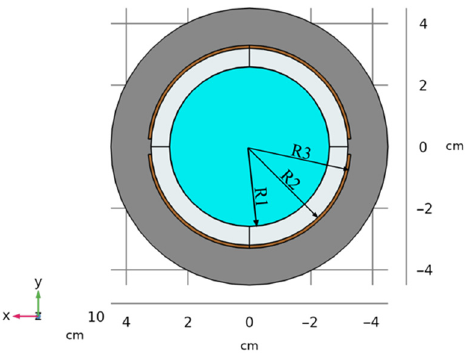
Figure 7. Cross-section diagram of the simulated capacitance-based sensor in the middle of the electrode.